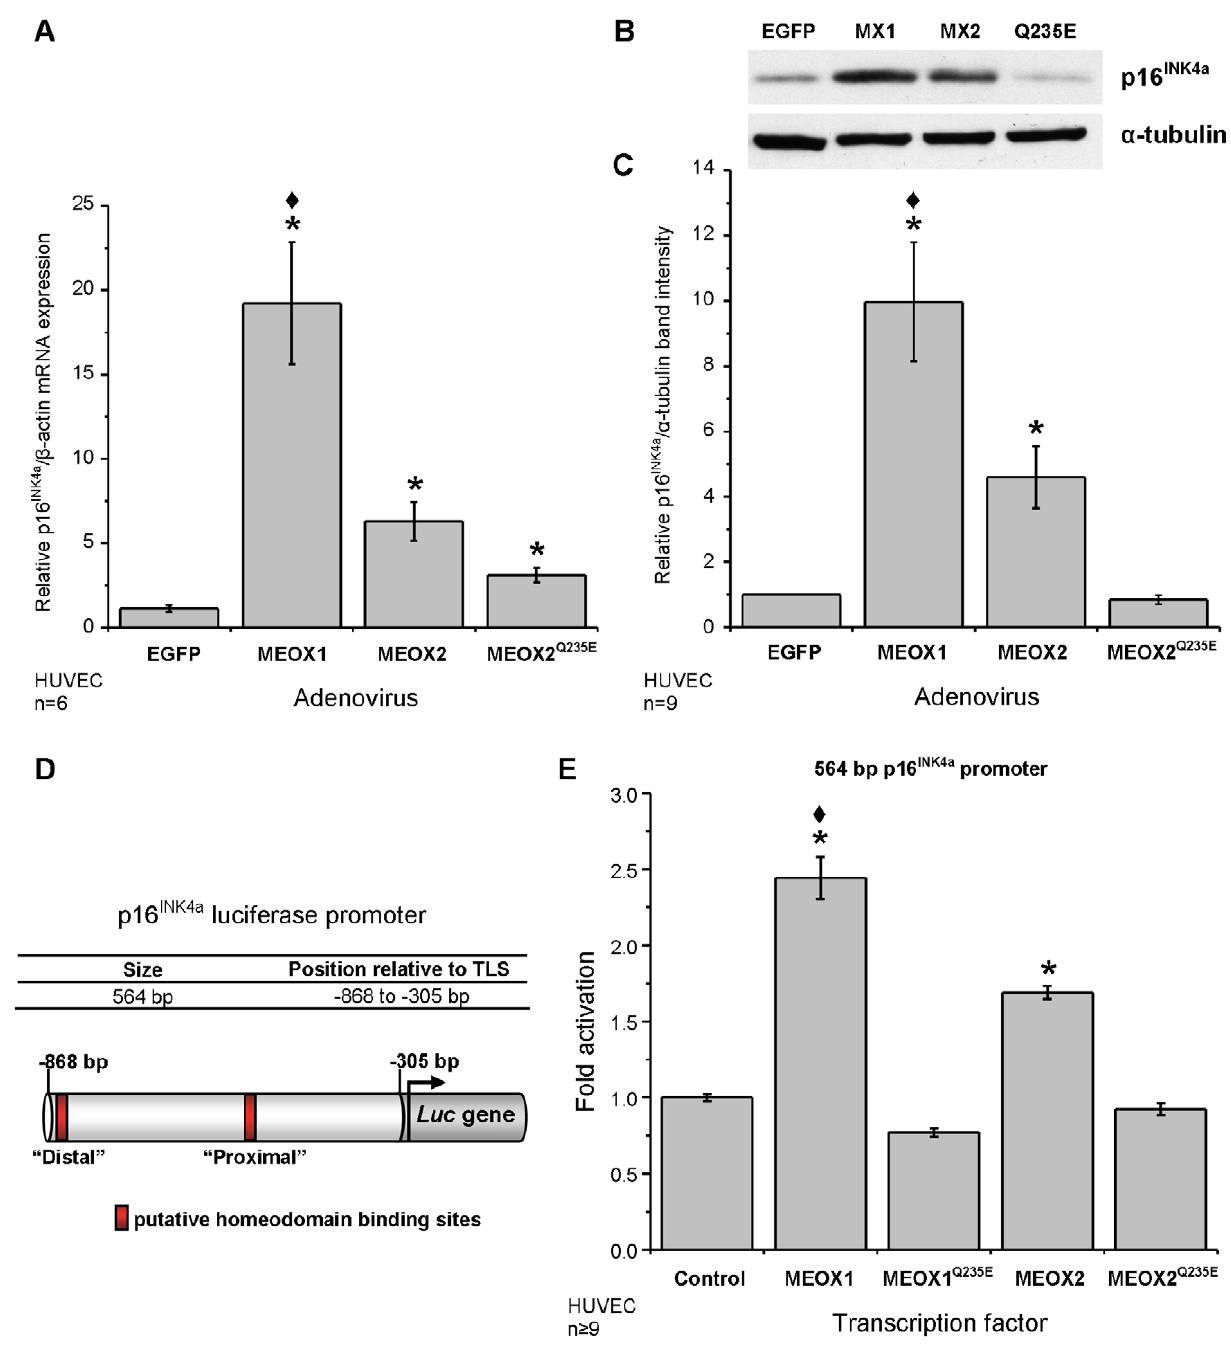
Figure 3. MEOX1 and MEOX2 activate transcription of the p16 INK4a gene in HUVECs. A) Relative level of p16 INK4a mRNA in HUVECs. Total RNA was isolated from HUVECs 72 hours after adenoviral transduction at a multiplicity of infection (MOI) of 250 and the amount of p16 INK4a mRNA was measured by quantitative real-time PCR and compared to EGFP transduced HUVECs. Beta-actin mRNA expression was used for inter-sample normalisation. MEOX1 is a more potent activator of p16 INK4a than MEOX2. B) A representative western blot showing increased p16 INK4a protein in HUVECs expressing ectopic MEOX1 (MX1), MEOX2 (MX2), but not DNA binding mutant MEOX2 Q235E (Q235E). Total protein was isolated from HUVECs 72 hours after adenoviral transduction at 250 MOI. C) Quantification of the relative amount of p16 INK4a protein compared to EGFP transduced HUVECs. The intensity of the p16 INK4a band was normalized to the tubulin loading control. D) Schematic diagram of the human p16 INK4a promoter luciferase construct used in this paper. The base pair positions are indicated relative to the translational start site. E) Activation of the luciferase reporter gene from the 564 bp p16 INK4a promoter by wild type MEOX1 and MEOX2 but not by the DNA binding domain mutant versions of MEOX2 (MEOX2 Q235E ) or MEOX1 (MEOX1 Q220E ). Luciferase assays were performed in HUVECs. * Indicates a statistically significant change (p , 0.05) when compared to the empty vector or EGFP control. ¤ Indicates a statistically significant difference (p , 0.05) between MEOX1 and MEOX2.